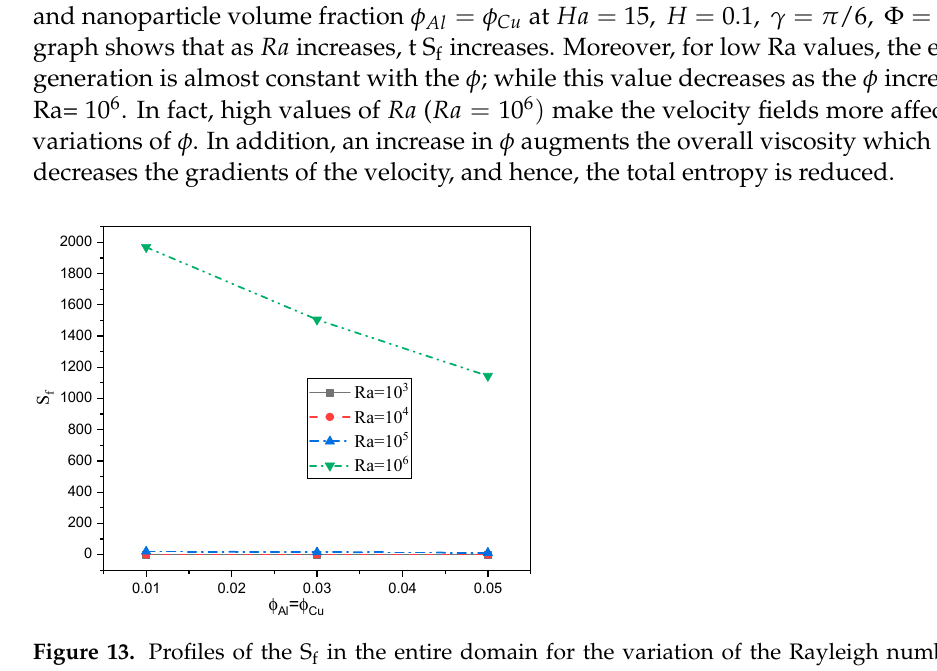
. (cid:2871) . . 3 (cid:2871)